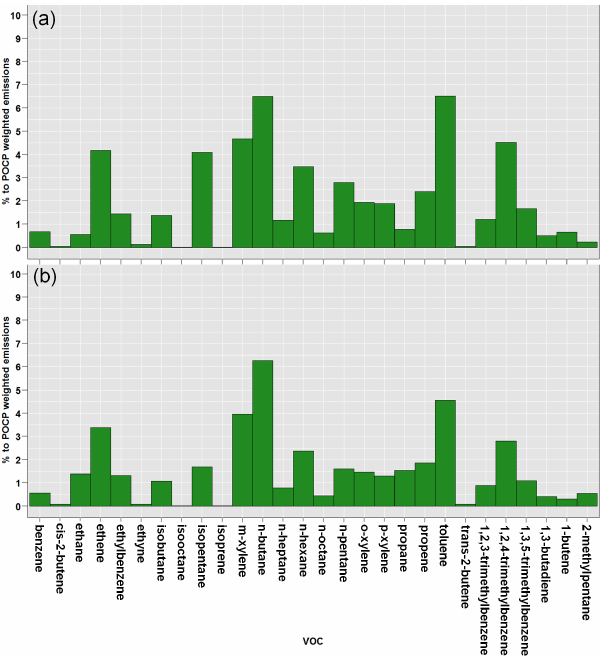
Figure 12. Speciation of average VOC back-trajectory emission es- timates in (a) July 2001, and (b) July 2011 at Harwell. The specia- tion was based on source profiles catalogued in Passant (2002) and the relative contribution of individual activities to annual total VOC